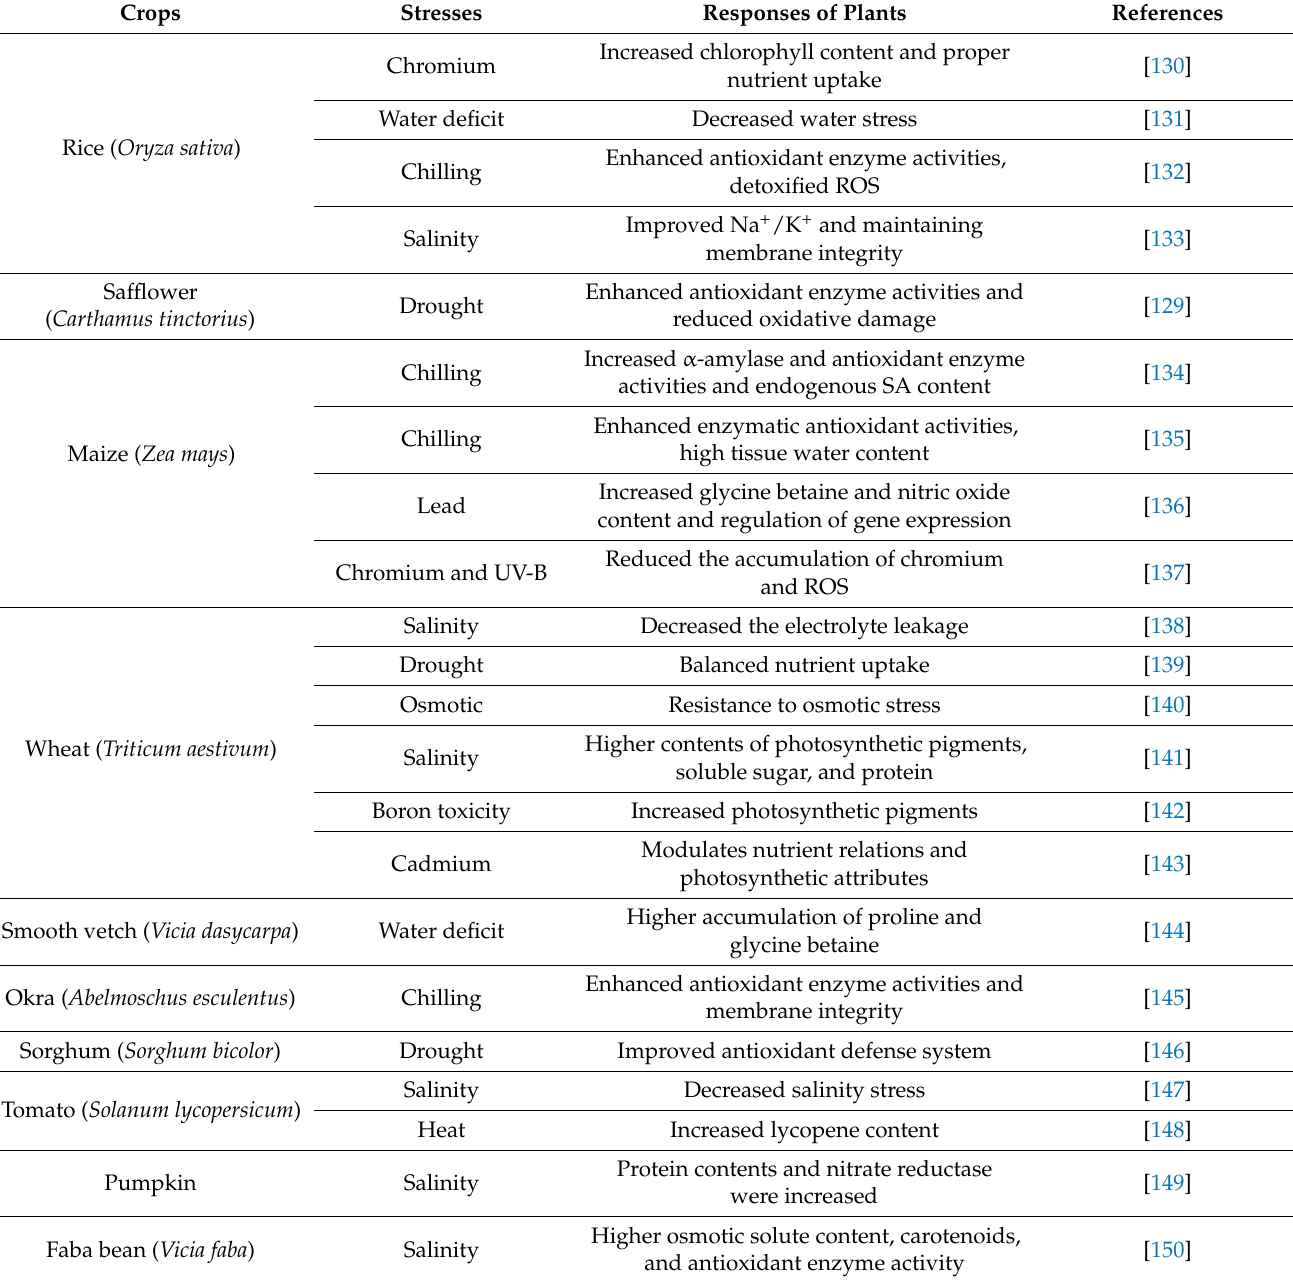
Table 3. Seed priming with salicylic acid (SA) and response of plant